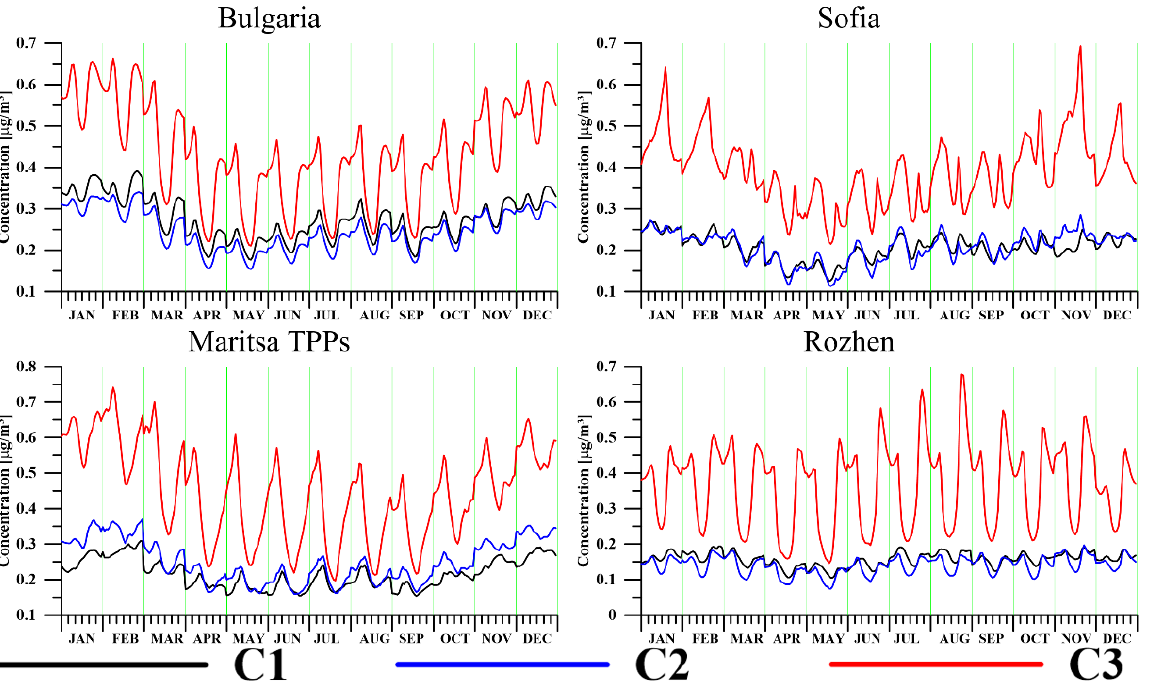
Figure 9. Diurnal and seasonal course of averaged over the ensemble surface concentrations of PM 2.5 [µg/m 3 ] for cases C1, C2 and C3.